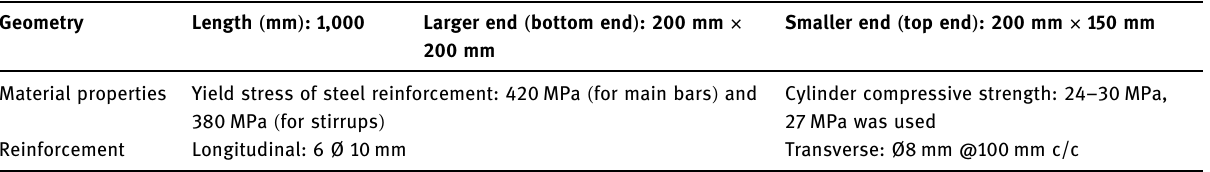
Table 3: Geometry and material properties of Model No. 3 Geometry